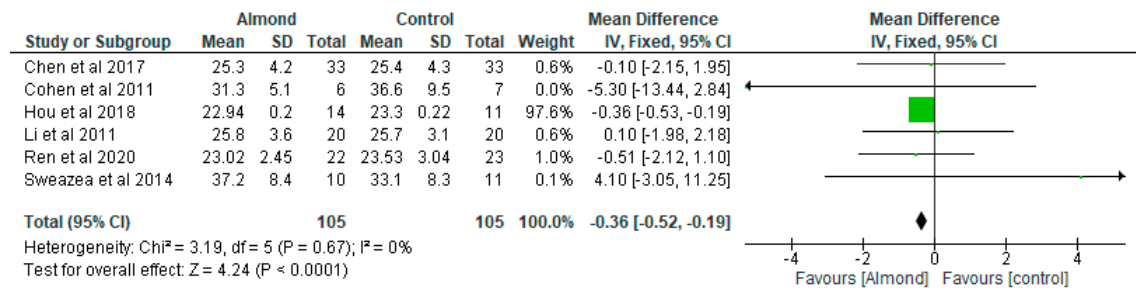
Figure 5. The effect of almonds on body mass index (Kg/m 2 ).